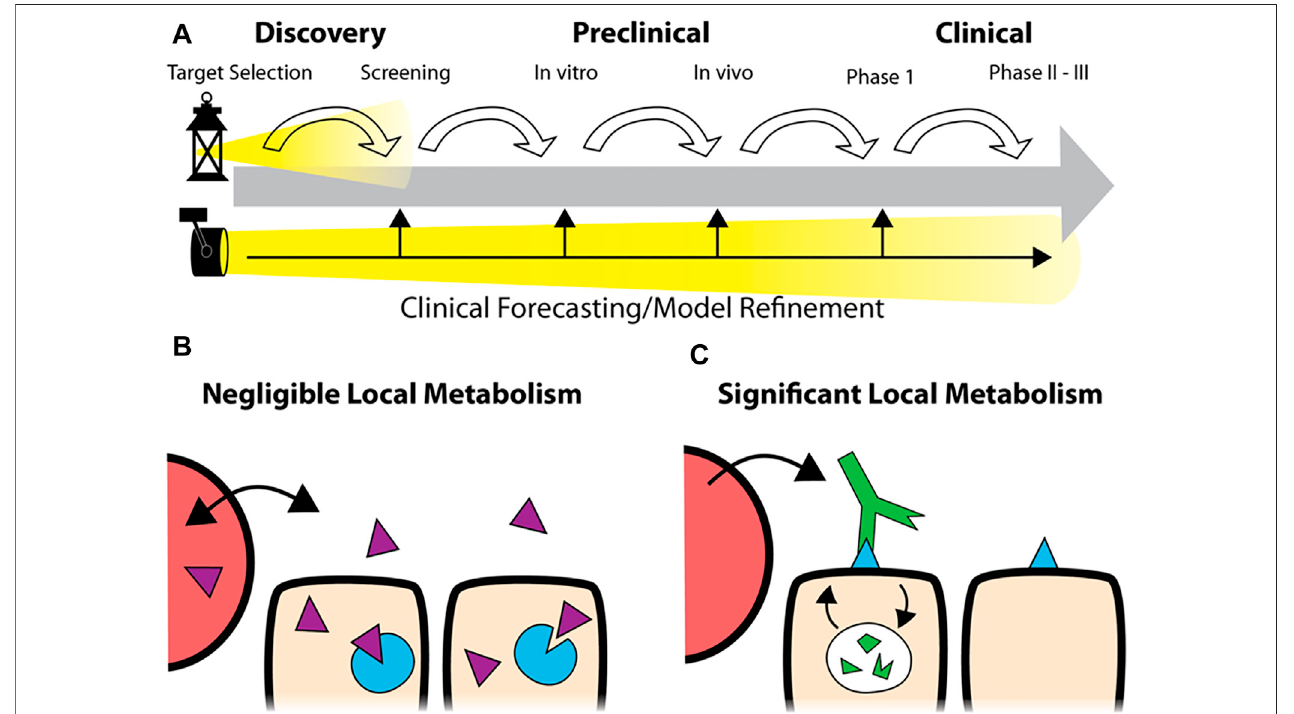
FIGURE 1 | Predictive Simulations in Development. Rather than focusing on each step in the pipeline (A) , top, robust simulations of drug distribution can be employed at the earliest stages of development to forecast clinical application. During development, the predictions can be re fi ned to improve the accuracy of the forecast or identify discrepancies (A, bottom). While predictive models for small molecule drugs typically assume tissue concentrations proportional to the plasma concentration due to fast distribution (B) , the local metabolism/degradation of biologics and slow tissue penetration require alternative approaches for accurate predictions (C)